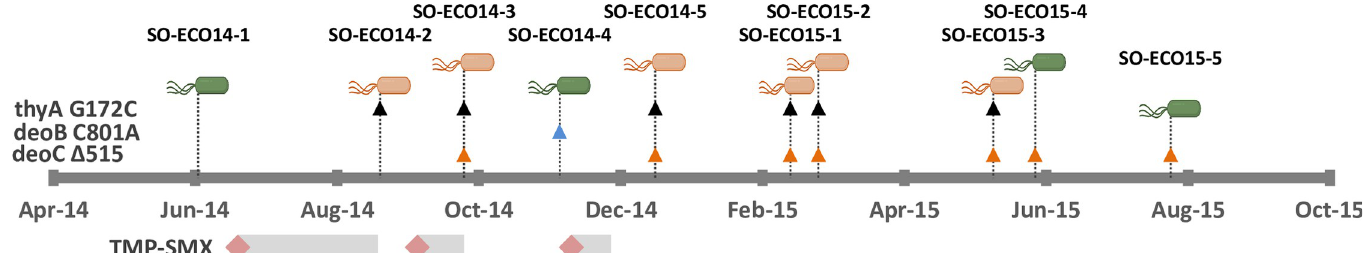
Fig 1. Timeline of E . coli BSI episodes (above line) and TMP-SMX antimicrobial treatment (below line). Isolated isolates are marked as susceptible (green) or resistant (red) to TMP-SMX. Mutations identified in thymidylate synthesis pathway genes include thyA G172C (black triangle), causing Glu58Gln in thymidylate synthase; deoB C801A (blue triangle), causing a premature stop codon in deoB ; and a 515 bp deletion ( Δ ) in deoC (orange triangle).